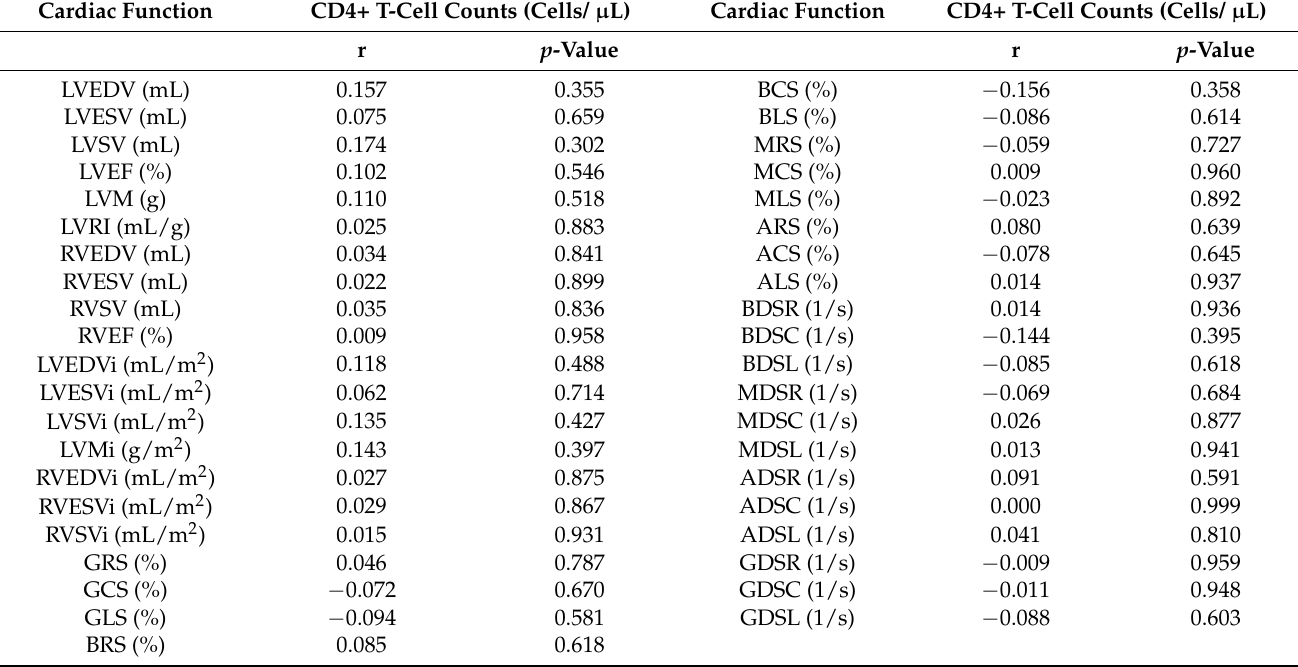
Table 5. Correlation between CD4+ T-cell counts and CMR indices.